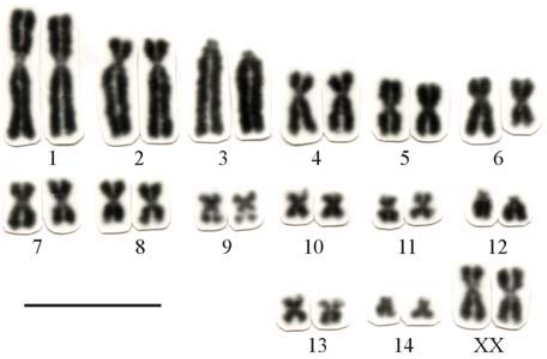
Figure9 -KaryomorphGconventionallystainedwith2n=30,FN=52of P. gr. longicaudatus fromUsinaHidrelétricaSamuel(RO).Bar=10 (cid:1) m.